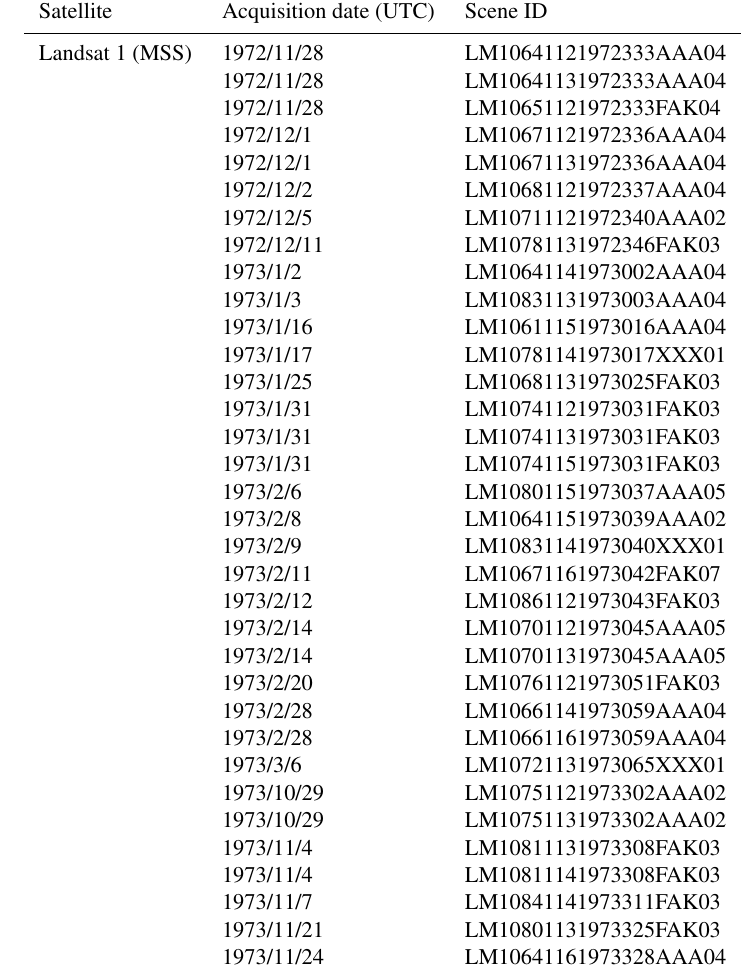
Table A3. Information for the Landsat images used for velocity mapping in Experiment